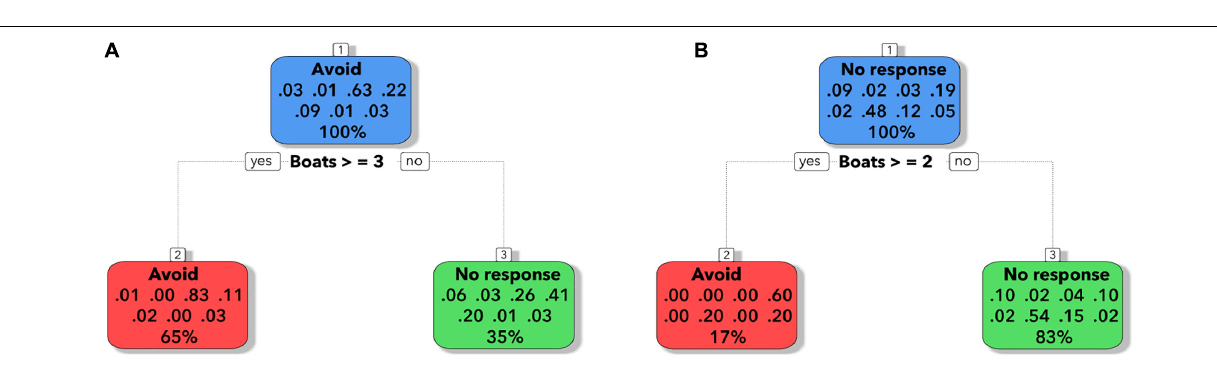
FIGURE 6 | The decision trees show the predicted probability of avoidance or no response for the Punta de Choros dolphin encounters groups (A) and Chañaral de Aceituno dolphin encounters groups (B) . Note that the two probabilities add to 100%. The proportion is 100% for the root